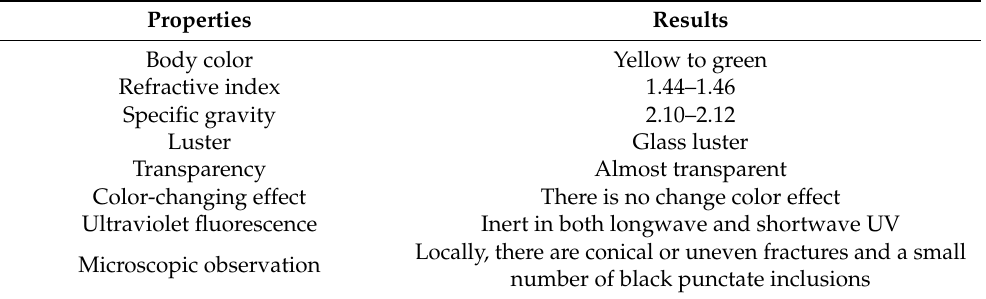
Figure 1. The samples used in this study under standard D65 light. Table 1. Gemological properties of opal samples.